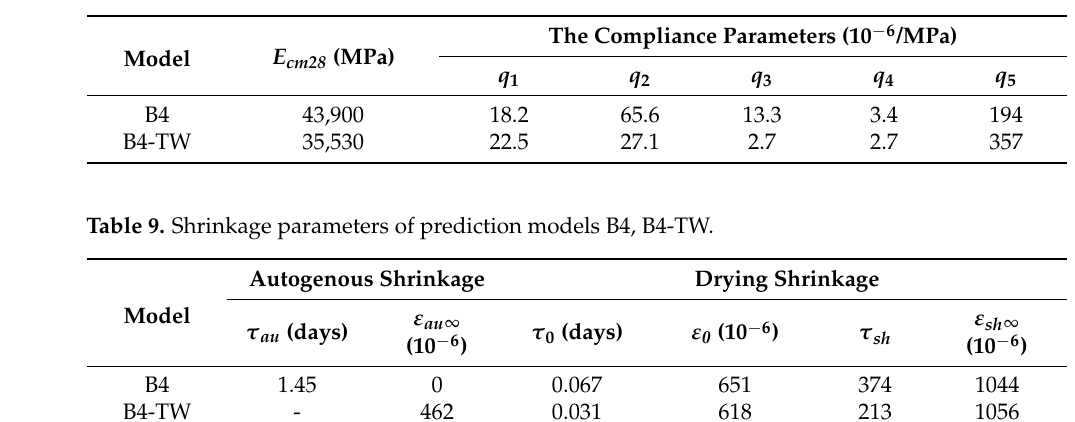
Table 8. Creep parameters of prediction models B4, B4-TW.